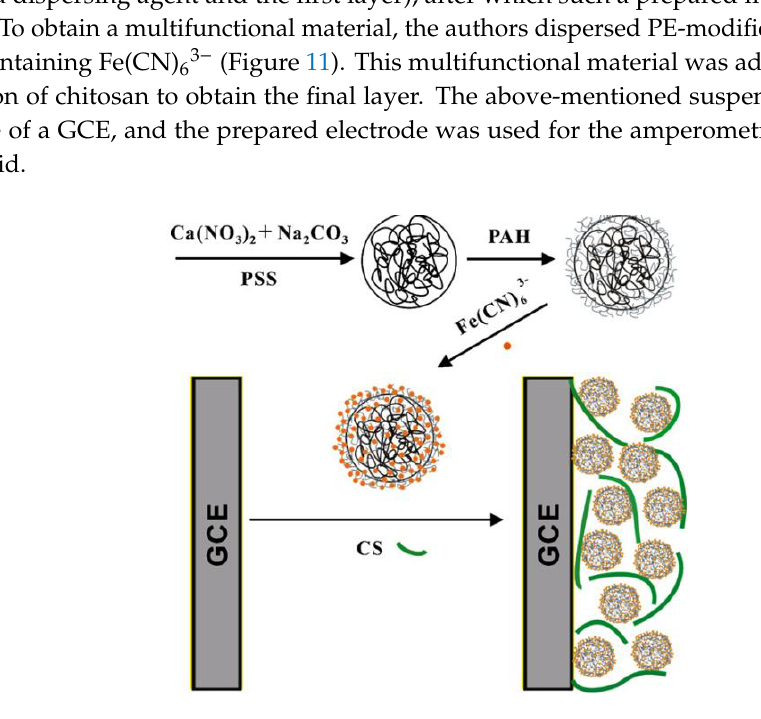
Figure 11. Schematic presentation of the fabrication of ascorbic acid sensor based on porous PE − CaCO 3 microspheres containing an Fe(CN) 63 − ions modified GCE. Reprinted from [93] with permission from the Elsevier.